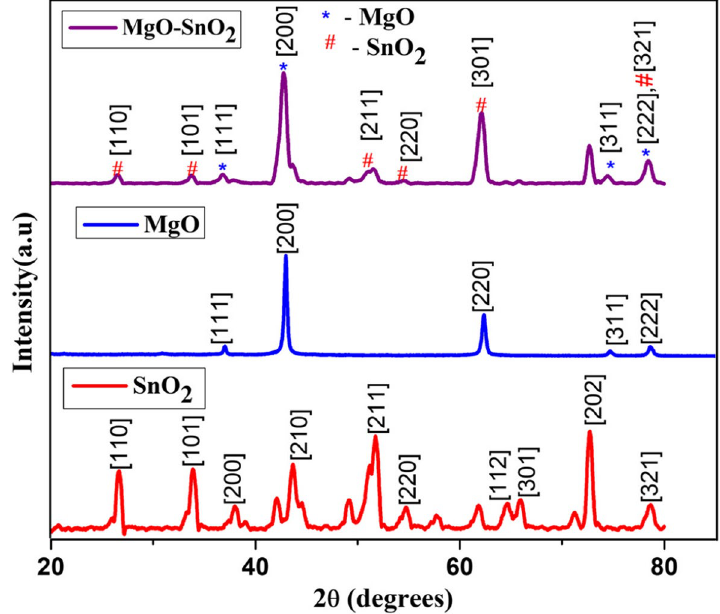
Fig. 1 X-ray diffraction pattern of MgO-SnO 2 nanocomposites under thermal decomposition (600 °C) for 20 min and calcination at 600 °C for 2